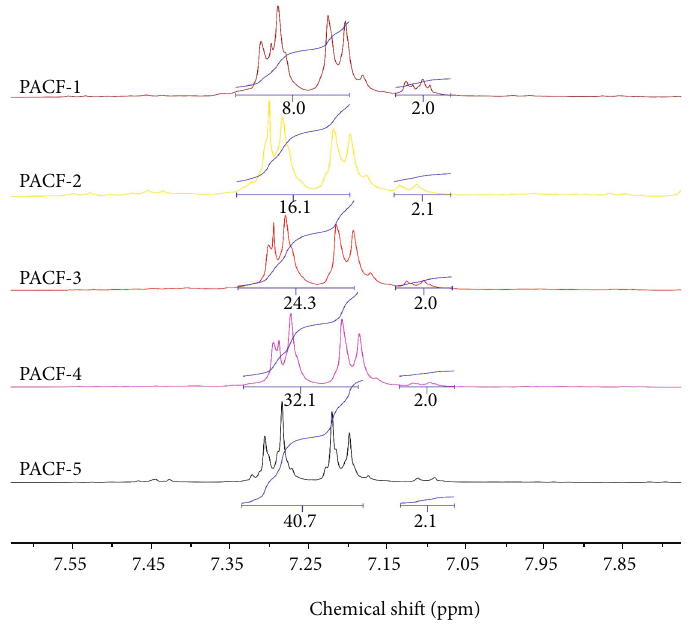
Figure 2: 1 H NMR spectra of PAFCs. Table 1: List of the proton NMR